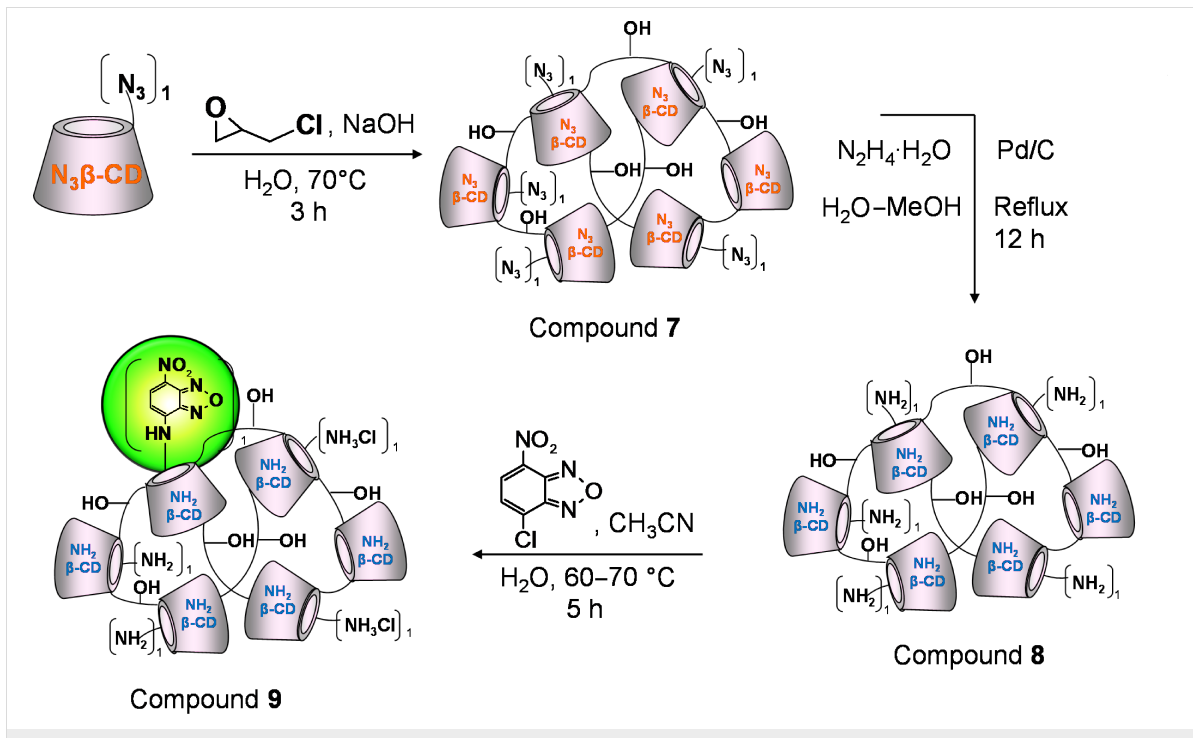
Scheme 4: Schematic representation for the introduction of NBF in a cationic β -CD-polymer.